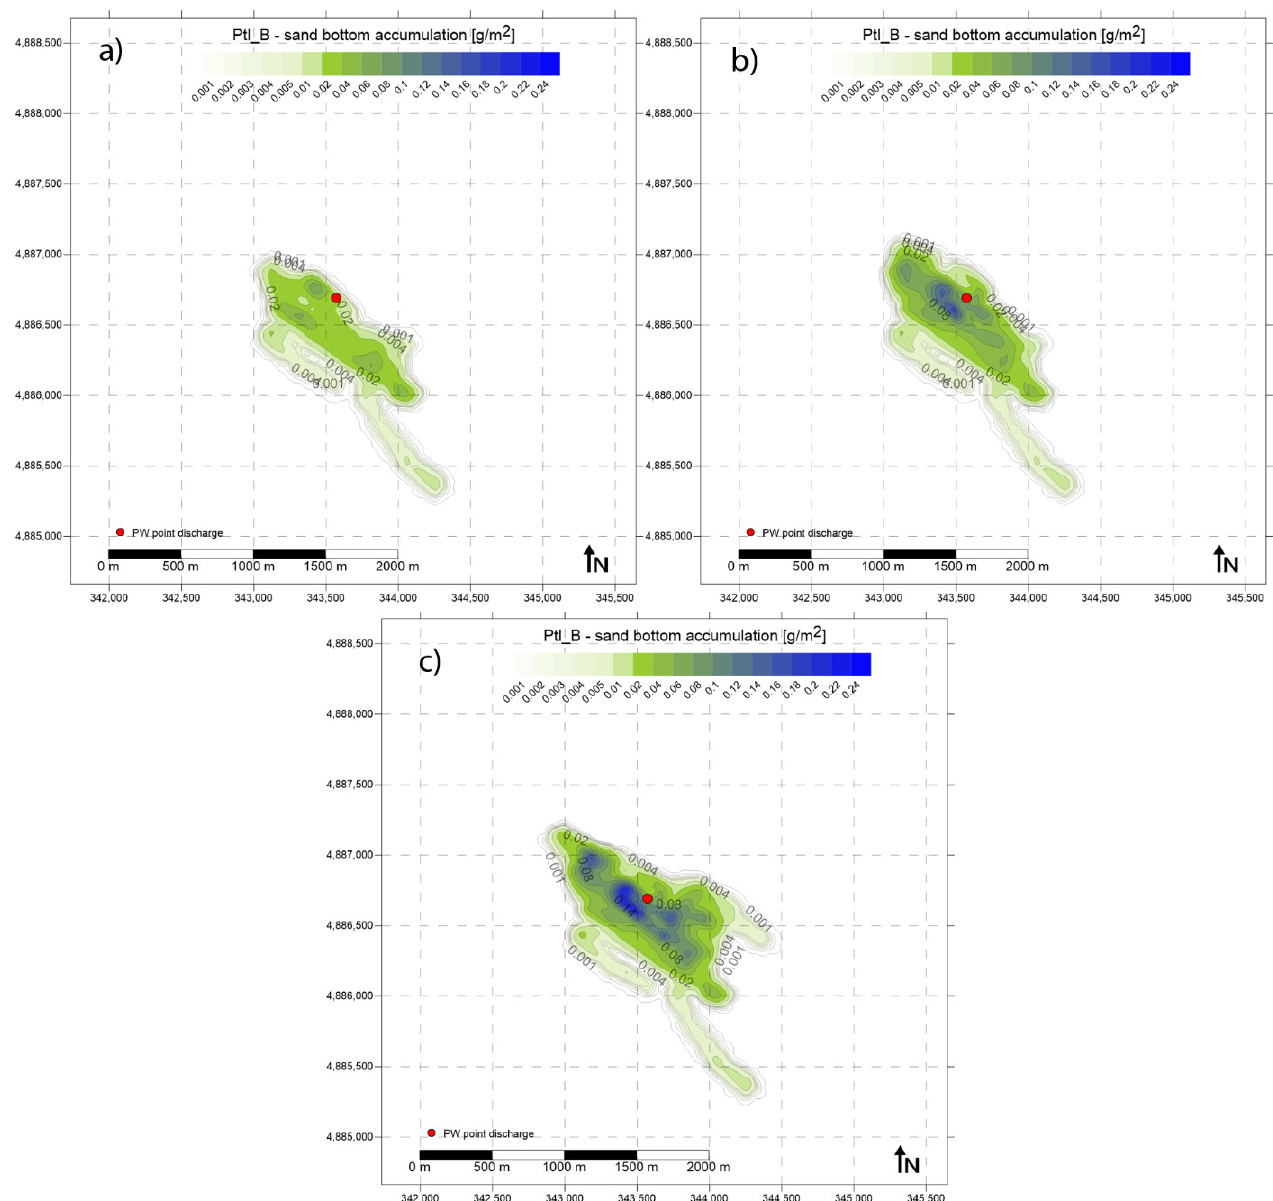
Figure 10. Map (WGS 84 UTM 33N) of sand bottom accumulation ( a ) after 10 days, ( b ) after 20 days, and ( c ) after one month as result by MIKE 3 PT module output for Plt B (red dot).